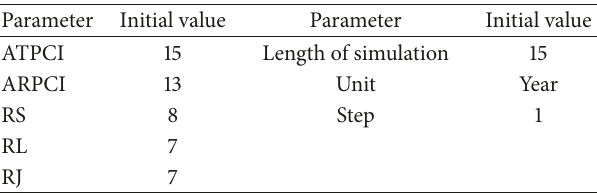
Table 2: Initial values of parameters.